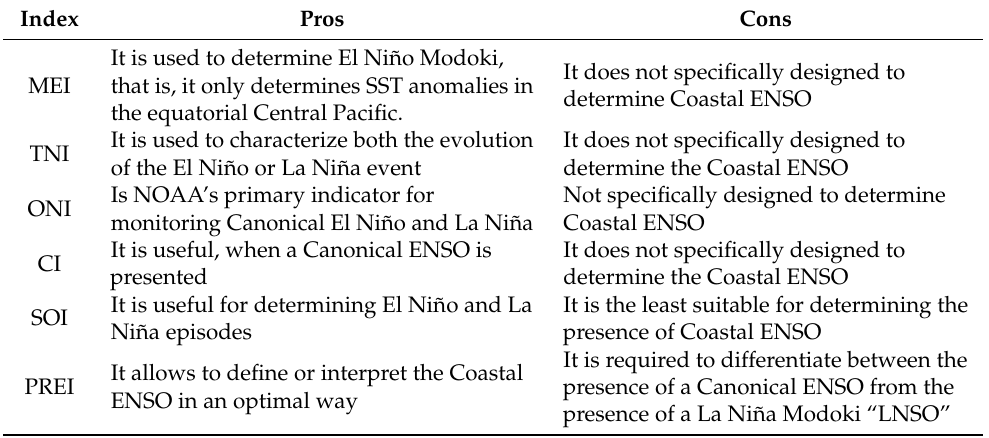
Table 2. Comparison of the pros and cons of ocean